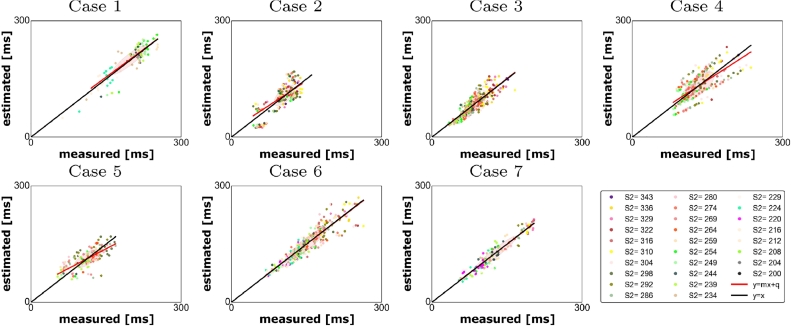
Measured vs estimated activation times for the personalised model (HRA). Each point represents a measured vs computed LATs at each electrode and for each s2; each colour represents the measurements taken at the electrodes for a fixed s2 value.